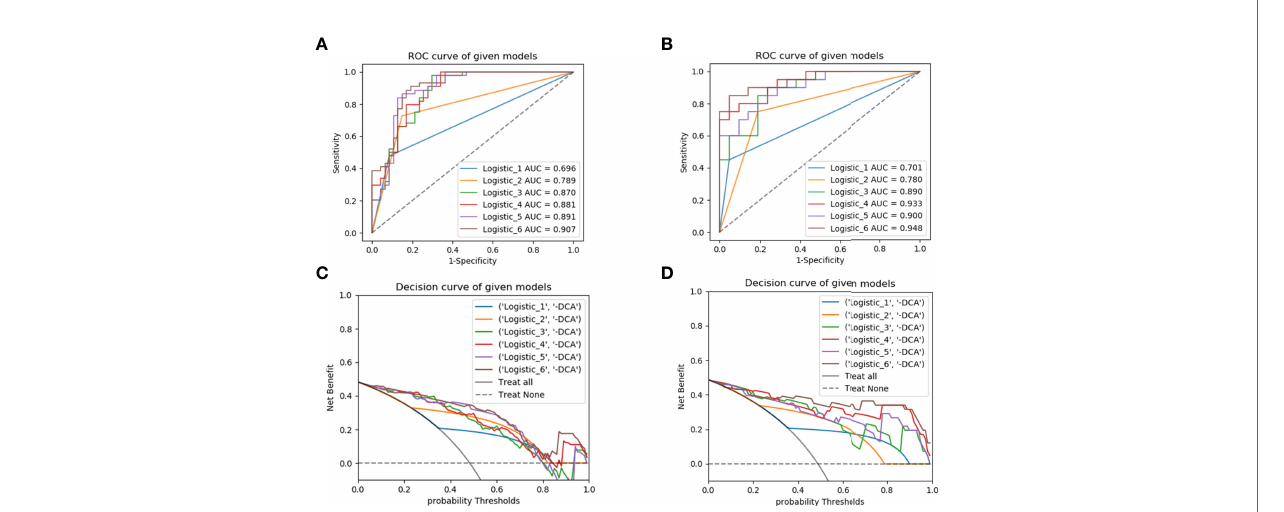
FIGURE 5 | ROC curves for predicting early recurrence with different models in the training (A) and test (B) sets; the decision curve analysis (DCA) in the training (C) and test (D) sets. ROC, receiver operating characteristic; Logistic_1, clinical model; Logistic_2, radiological model; Logistic_3, radiomics model; Logistic_4, radiomics-clinical model; Logistic_5, radiomics-radiological model; Logistic_6, combined